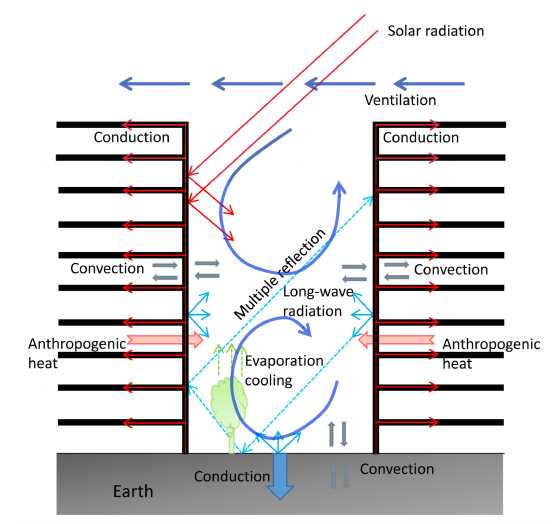
Figure 2. Schematic diagram of the energy fluxes in the microscale urban environment (drawn by